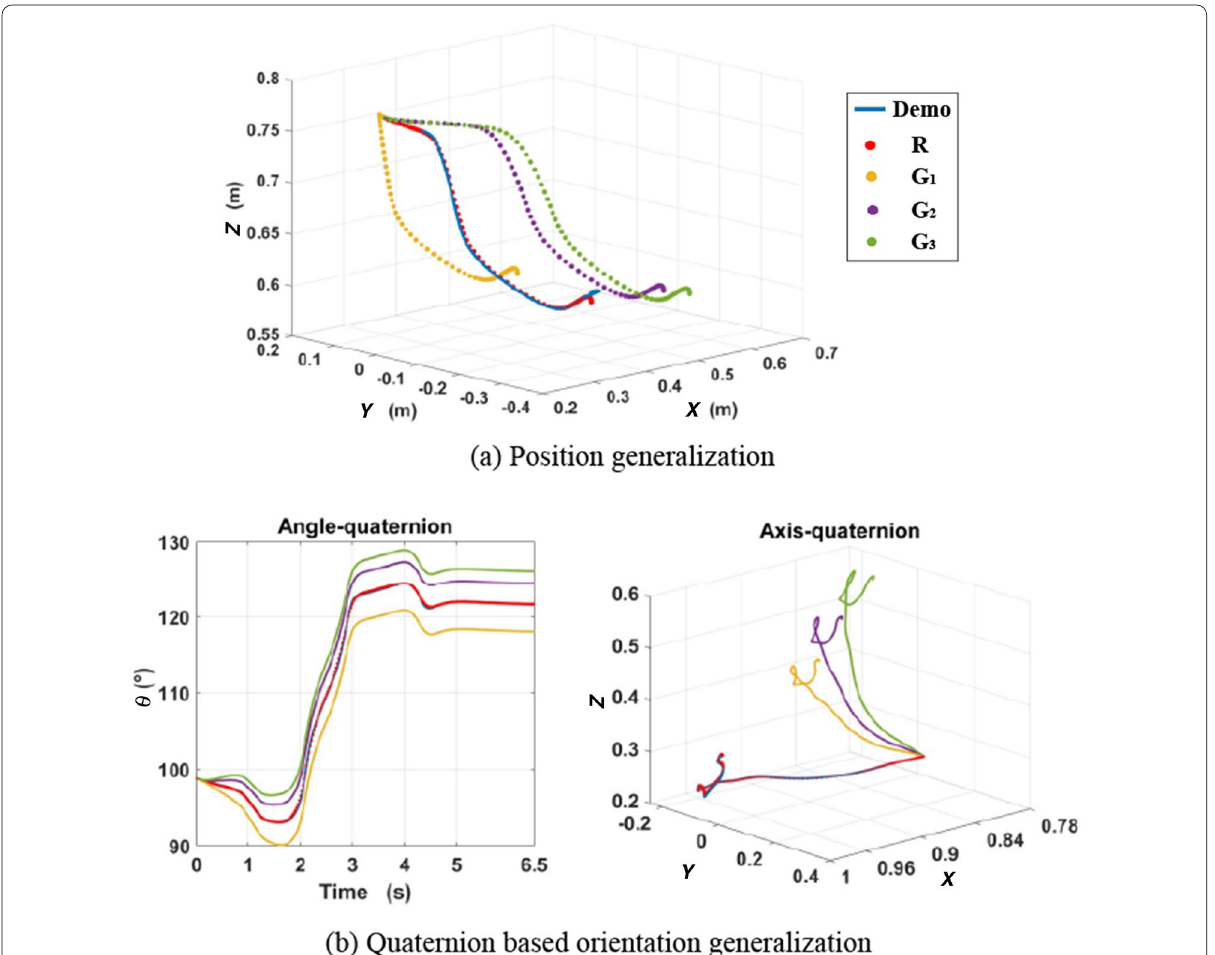
Figure 4 Generalization of positions and orientations